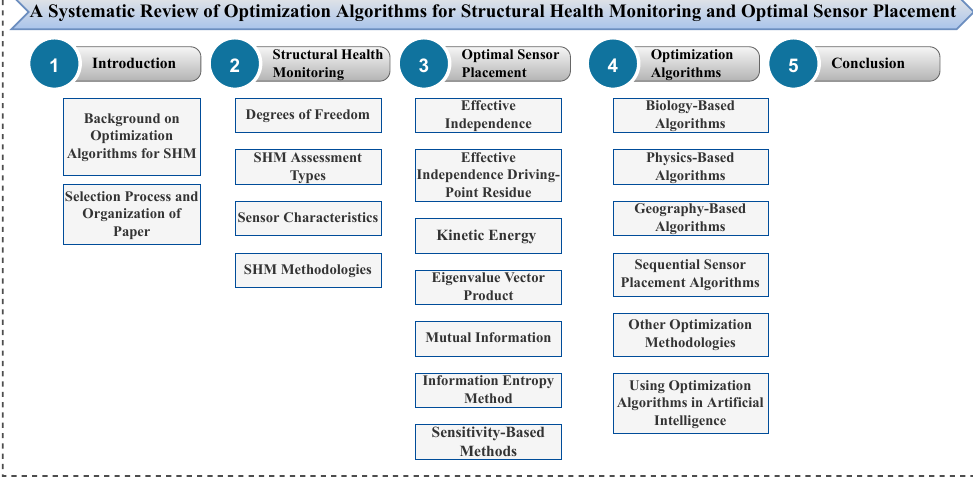
Figure 3. Structure of different sections of the